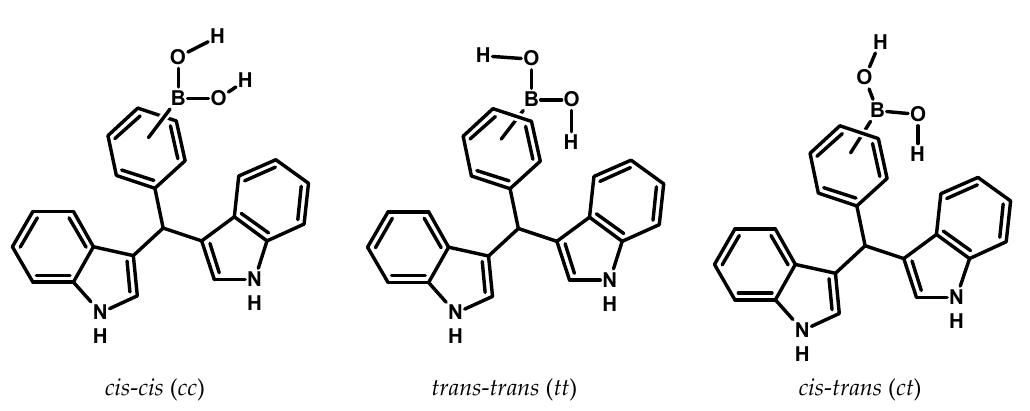
Figure 2. There is the possibility of forming three possible conformers, this depends on the location of the hydrogen atoms that are bonded to the oxygen atoms of the –B(OH) 2 group.